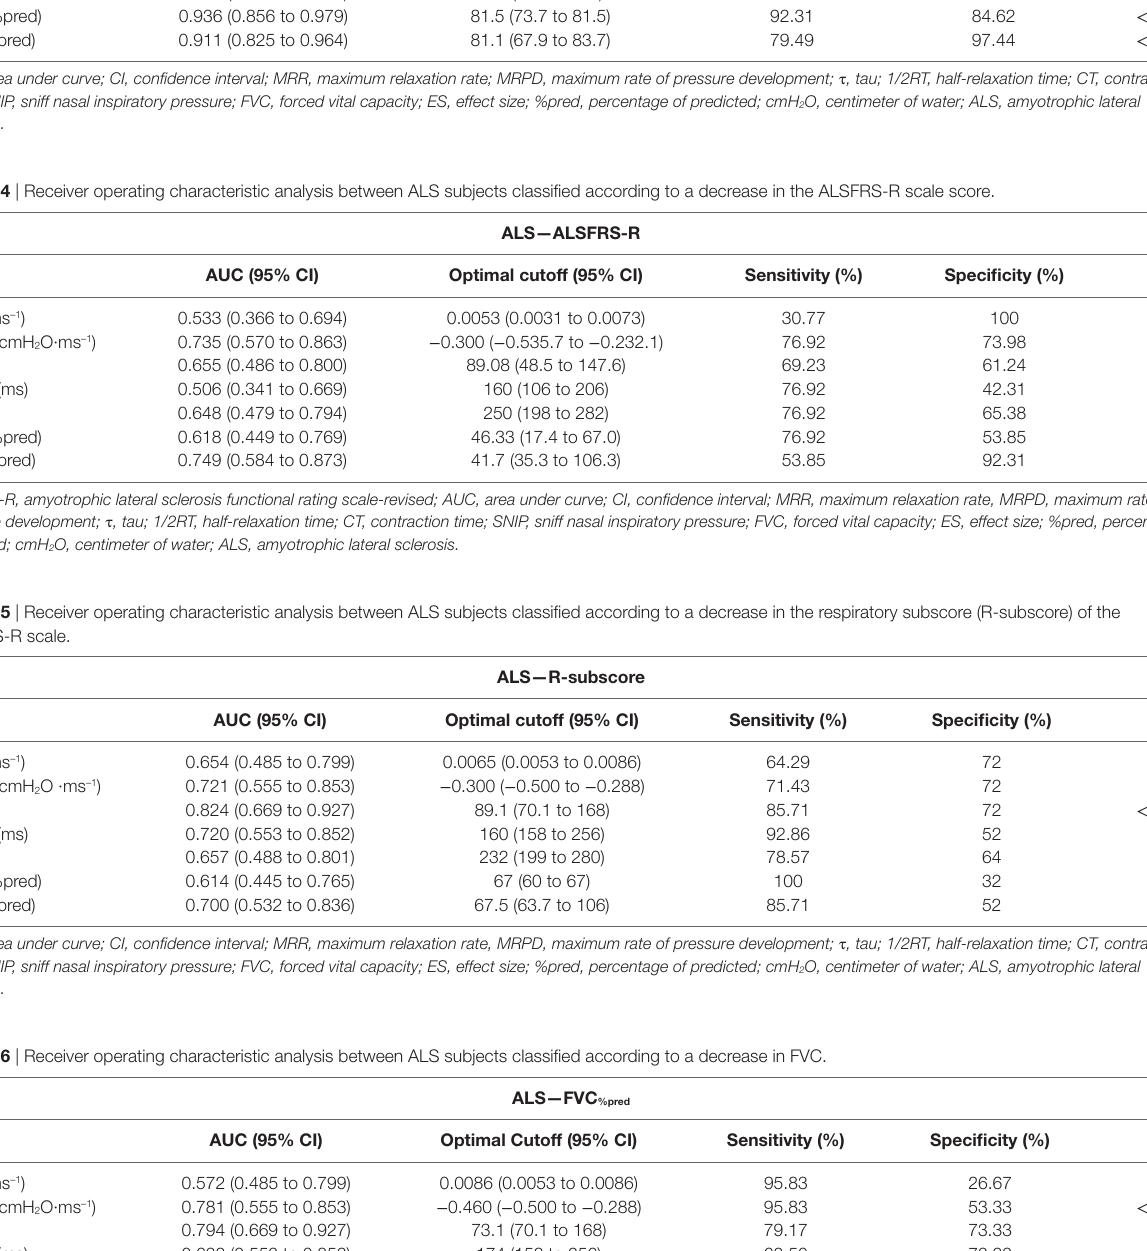
AUC, area under curve; CI, confidence interval; MRR, maximum relaxation rate, MRPD, maximum rate of pressure development; τ , tau; 1/2RT, half-relaxation time; CT, contraction time; SNIP, sniff nasal inspiratory pressure; FVC, forced vital capacity; ES, effect size; %pred, percentage of predicted; cmH 2 O, centimeter of water; ALS, amyotrophic lateral